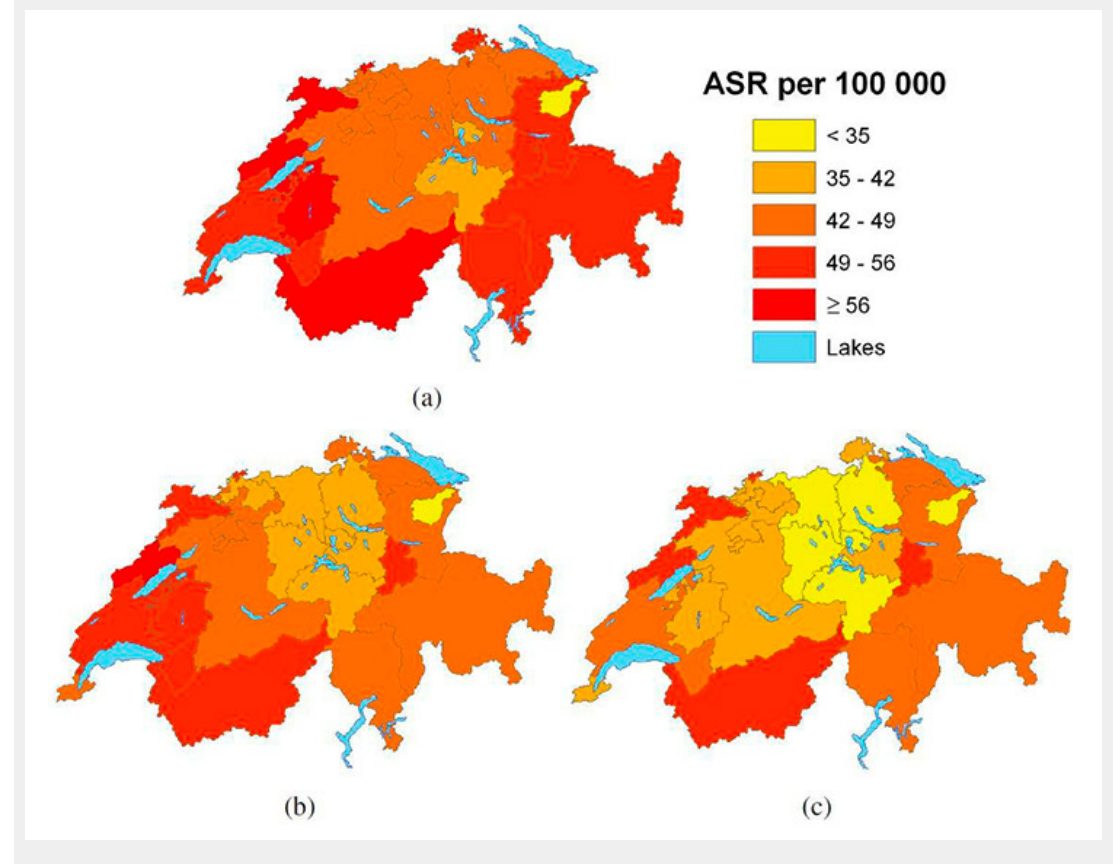
Figure 6 Age-standardised tobacco-related cancer mortality rates (per 100,000) for males age ≥50 years, (a) observed during 2004–2008 and predicted posterior median (b) during 2009–2013 and (c)